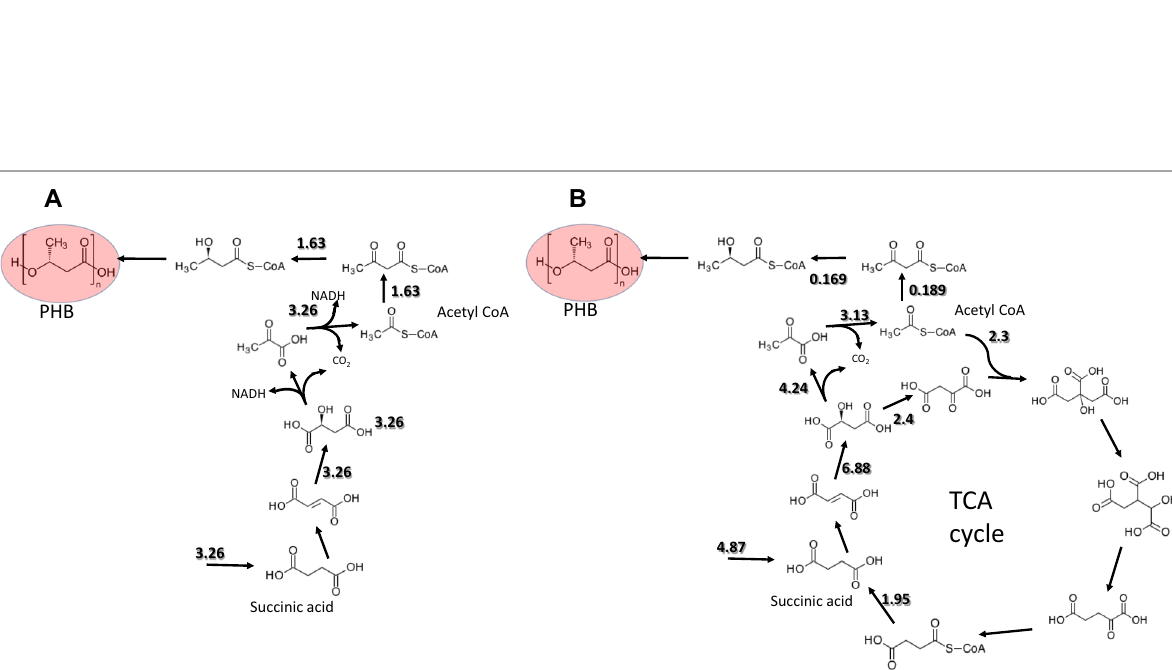
Fig. 3 Distributions of metabolic fluxes under PHB accumulation and exponential growth. The numbers are reaction rates in mmol g‑DW − 1 h − 1 . Only the main metabolic fluxes are